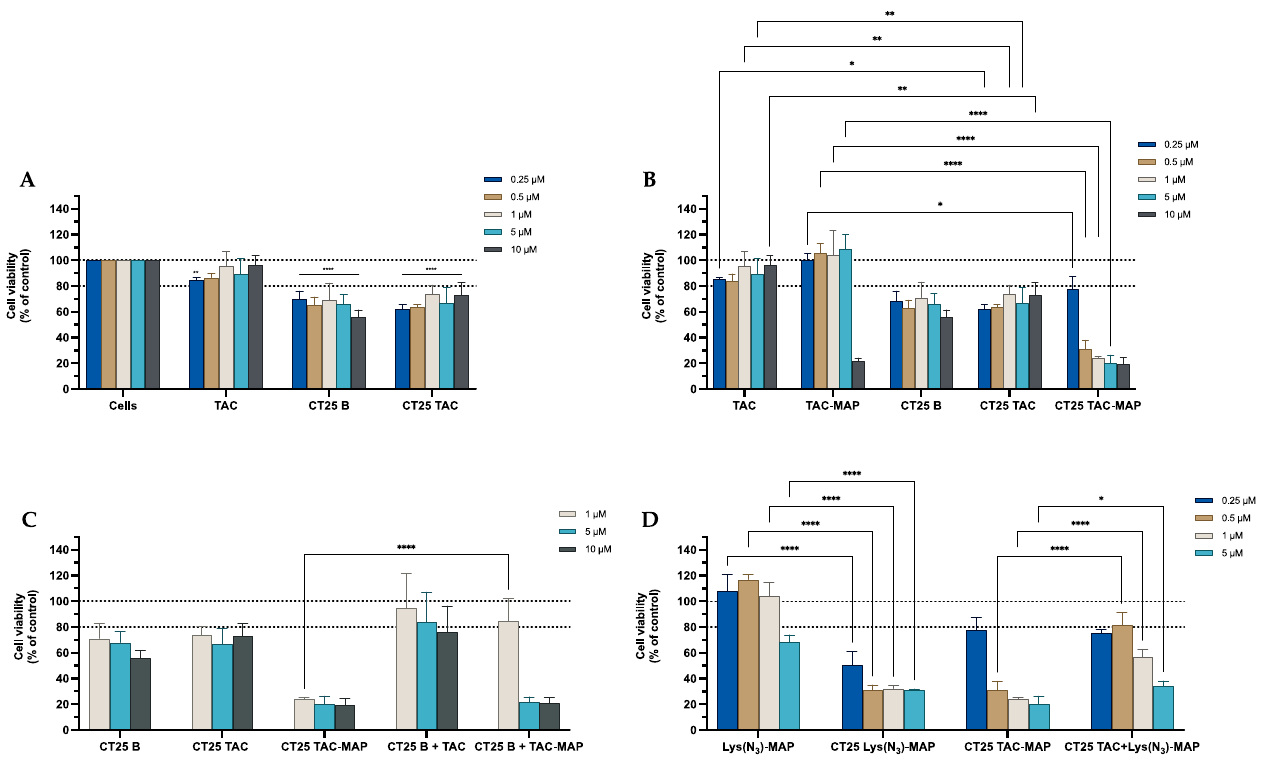
Figure 7. Relative cell viability of Caco-2 cell line measured by the MTT reduction after 24h incubation. ( A ) represents NLC safety test with the treatment of free TAC, blank CT25 and TAC-loaded CT25 (0.25–10 µ M). ( B ) Represents differences in the cell viability of treatment with free TAC, TAC-MAP, blank CT25, TAC-loaded CT25, MAP, TAC-MAP-loaded CT25 (0.25–10 µ M). ( C ) Represents co-administration of TAC and TAC-MAP with blank CT25 (1–10 µ M). ( D ) Represents the data obtained from the encapsulation of Lys(N 3 )-MAP and co-encapsulation of TAC and Lys(N 3 )-MAP in the NLC compared with peptide conjugate. Results are expressed as mean ± SD (n = 4). Statistical analysis between the groups was performed using two-way ANOVA with Tukey’s multiple comparisons test (* p < 0.05; ** p < 0.01; **** p < 0.0001).